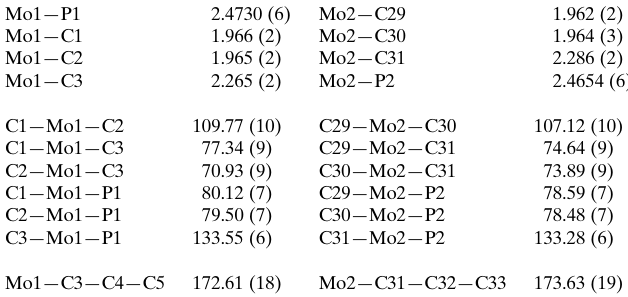
Table 2 Selected geometric parameters (A˚ , (cid:4) ) for ( 2 ).